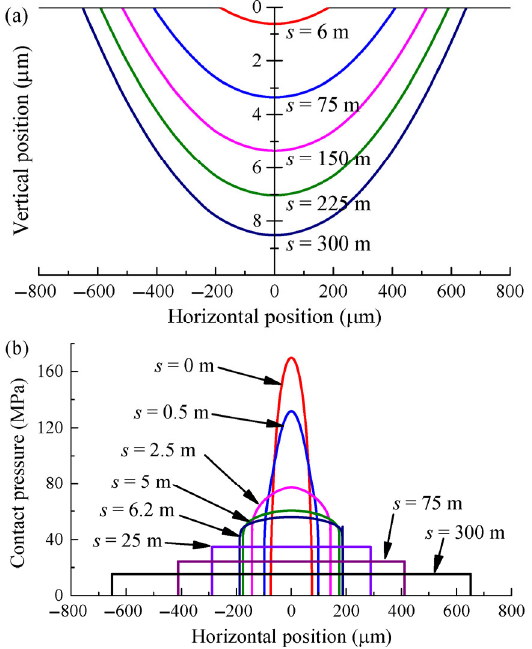
Fig. 9 Predicted wear profiles for block under different sliding